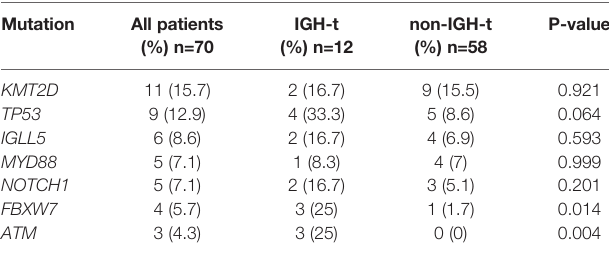
TABLE 4 | Mutation results of all patients and those in the IGH-t and non-IGH-t groups. Mutation All patients (%)